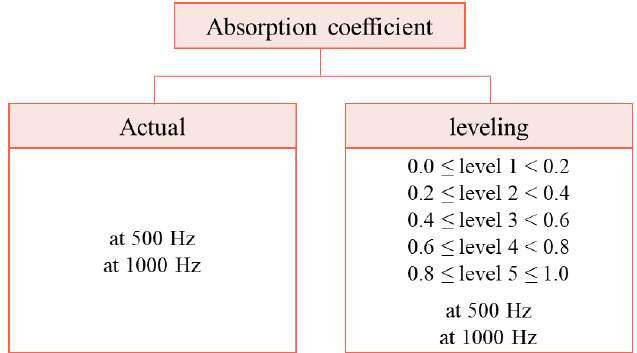
Figure 9. Data processing of sound absorption coefficient.